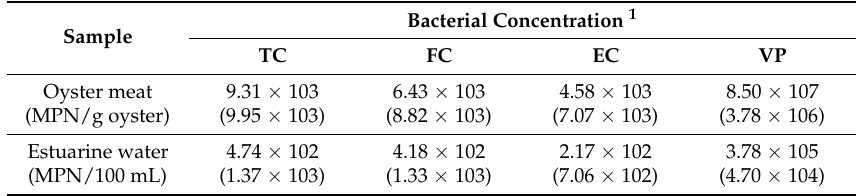
Table 1. The average concentration and standard deviation (MPN/g of oyster meat or MPN/100 mL of estuarine water) of TC, FC, EC, and VP in pooled cultivated oysters ( n = 144) and estuarine waters